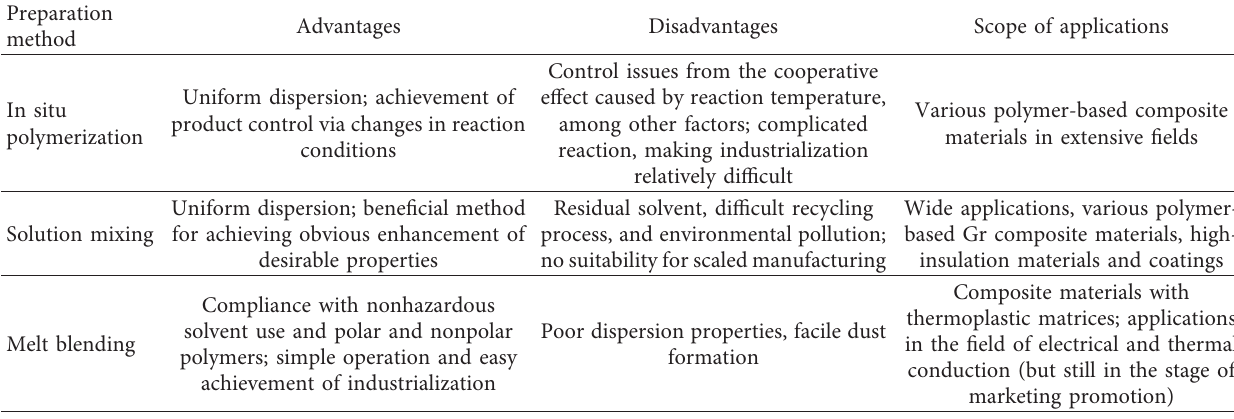
Table 5: Preparation methods, advantages, disadvantages, and the scope of applications of graphene/polymer composite materials [81–83].